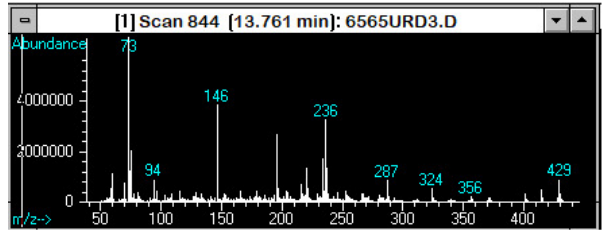
Figure 2. Mass spectrum of Morphine-TMS.